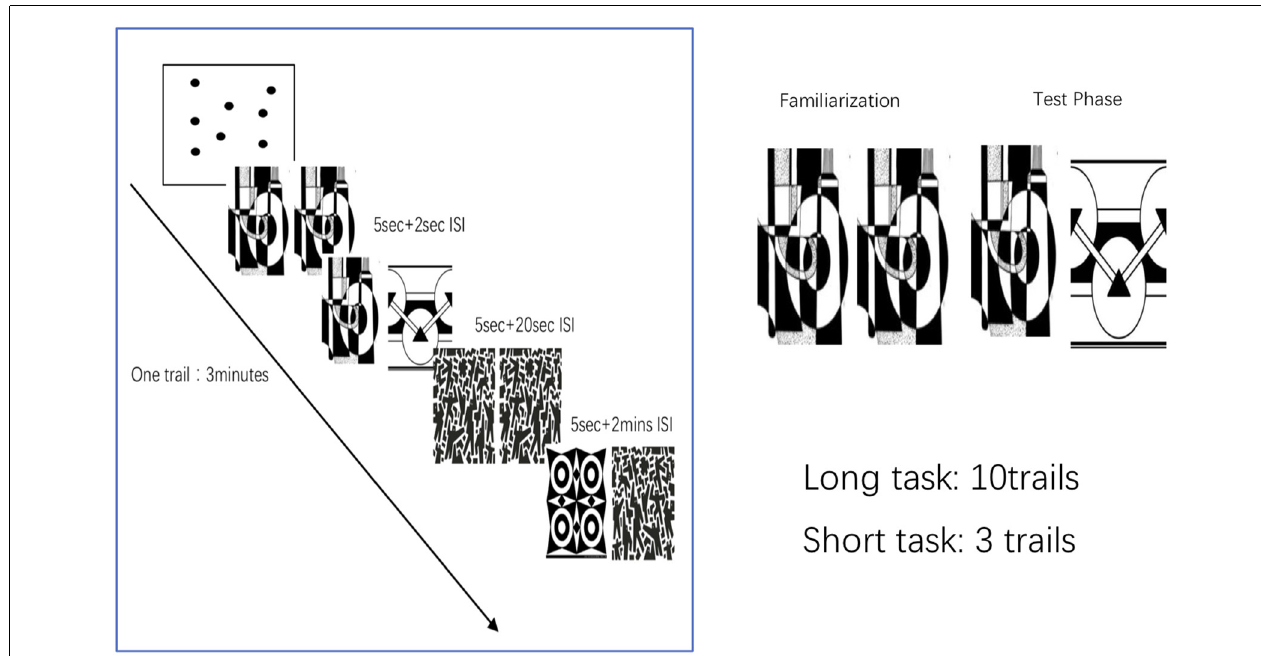
FIGURE 2 | Visual paired comparison task (VPC). Subjects were asked to complete the 9-point calibration procedure before taking the VPC task. During the familiarization phase, participants viewed the two identical pictures presented on the monitor side by side for 5 s. Next, the monitor went dark for a delay interval of either 2 s or 2 min. The test parameters consisted of the presentation of one previously presented image and the novel image. After the test phase, the monitor went dark for 20 s and the next task was initiated. For the long task, participants were administered two blocks of 10 trials (delay order: 2-s delay, 2-min delay) for total 20 trials. The short task contains three